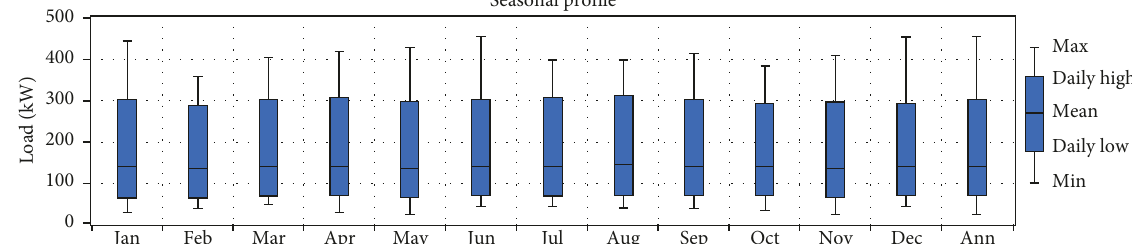
Figure 9: Seasonal load profile of each month in a year in Bligo village, central Java.